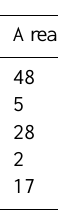
Figure 6. Measured and simulated phreatic levels for the monitoring point 39BL0020 2 Fig. 6. Measured and simulated phreatic levels for the monitoring point 39BL0020 indicated in Fig. 5. indicated in Fig. 5. 3 Table 1. Land use in the Kromme Rijn region. Figure 7. Simulated groundwater level for 2003 (highest and lowest levels), for the cross-2